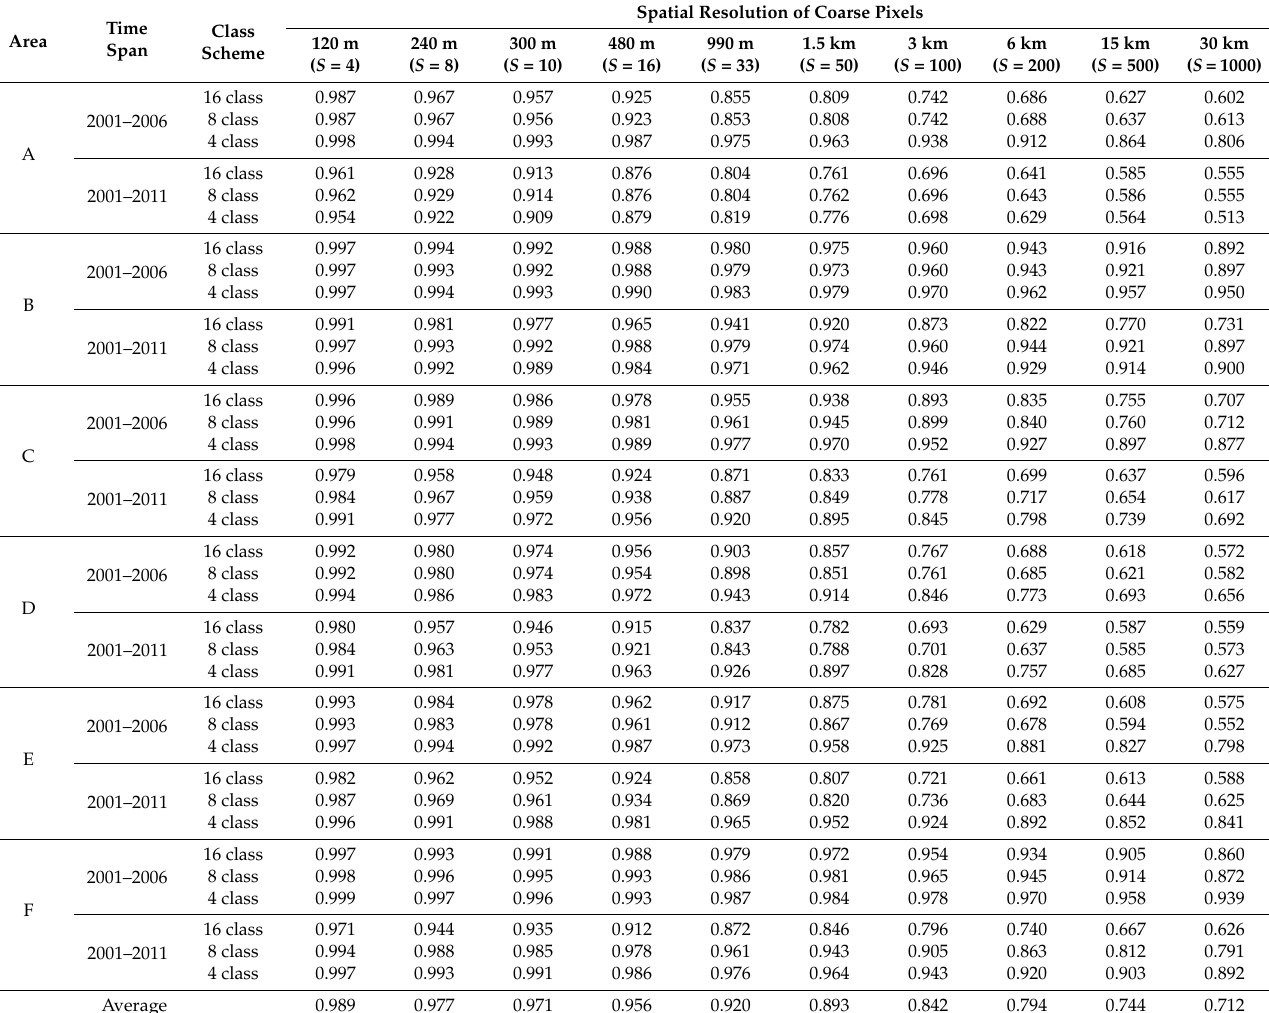
Table 3. A cs values for six study areas with different spatial resolution of coarse pixels, land cover class schemes and time